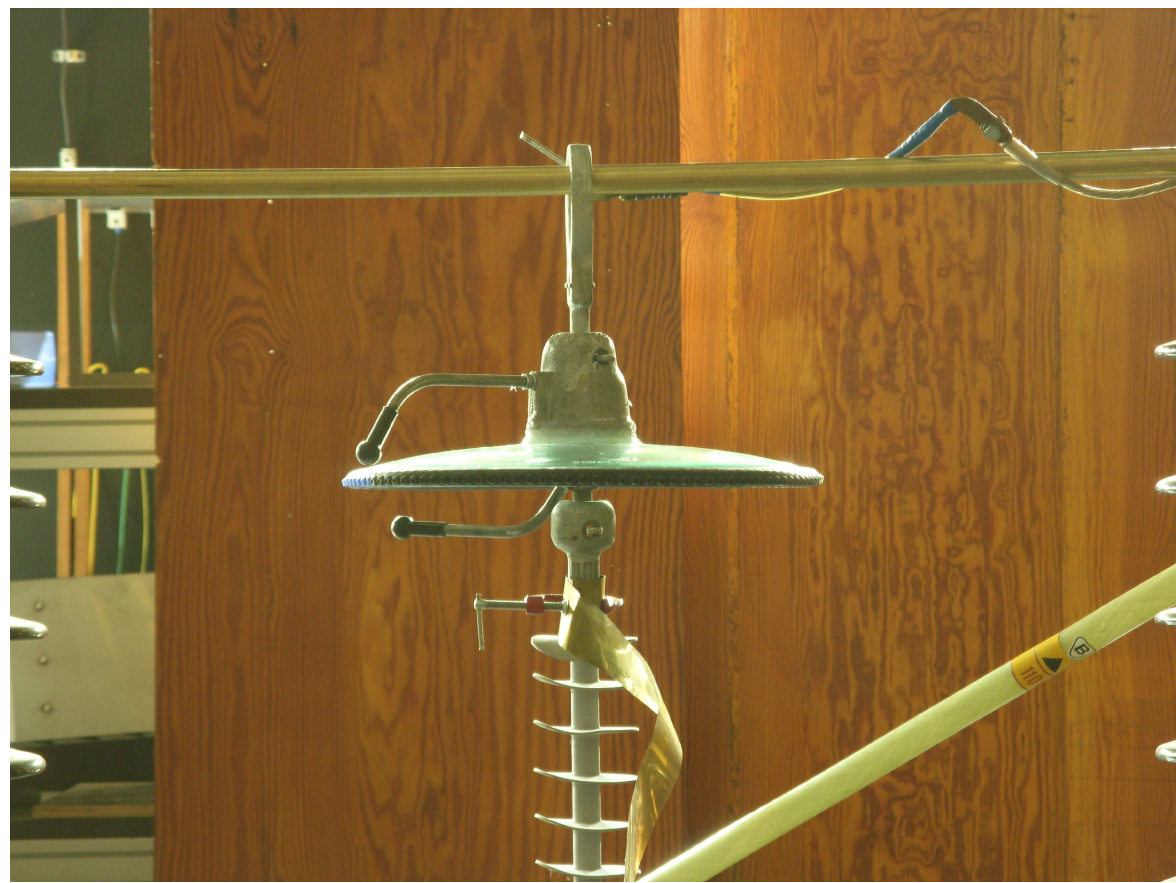
Figure 1. A multi-chamber loop-type arrester mounted around a single